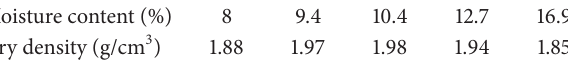
Table 4: Moisture content and dry